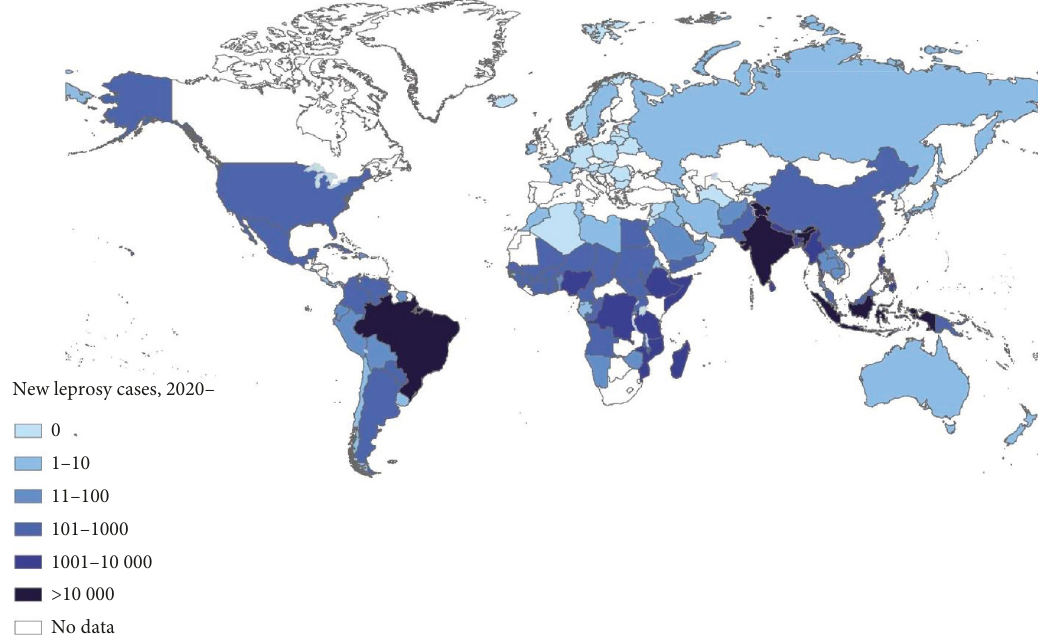
Figure 1: Global distribution of new leprosy cases in 2020 (source: World Health Organization/National Leprosy Program, WHO 2021)